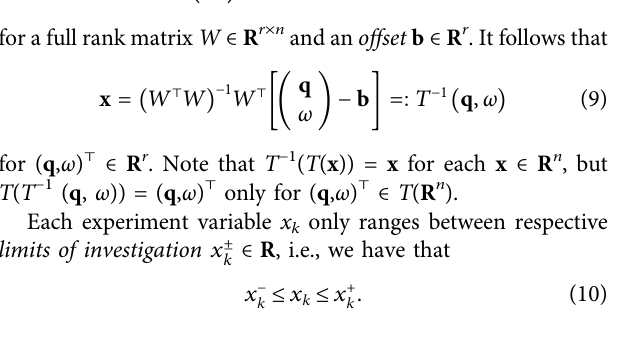
Frontiers in Materials |